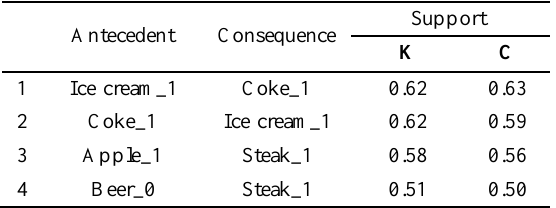
Table 5. Support distribution of rules of C in different data sets